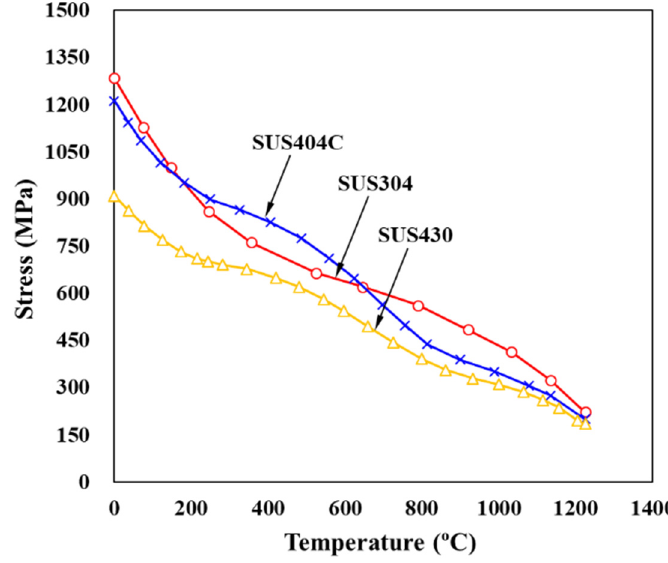
Figure 6. Dynamic strain aging of various stainless steels [105].